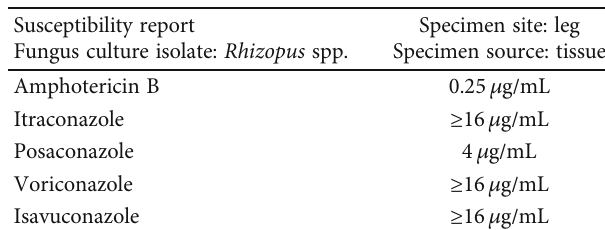
Table 2: Patient 1 susceptibilities.